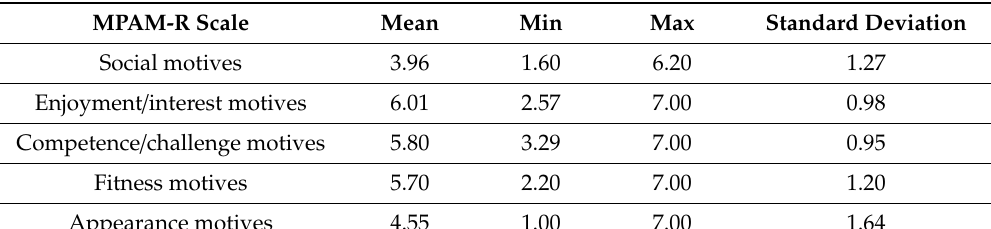
Table 1. Motives of the surveyed children. MPAM-R: Motives for Physical Activity Measure–Revised.